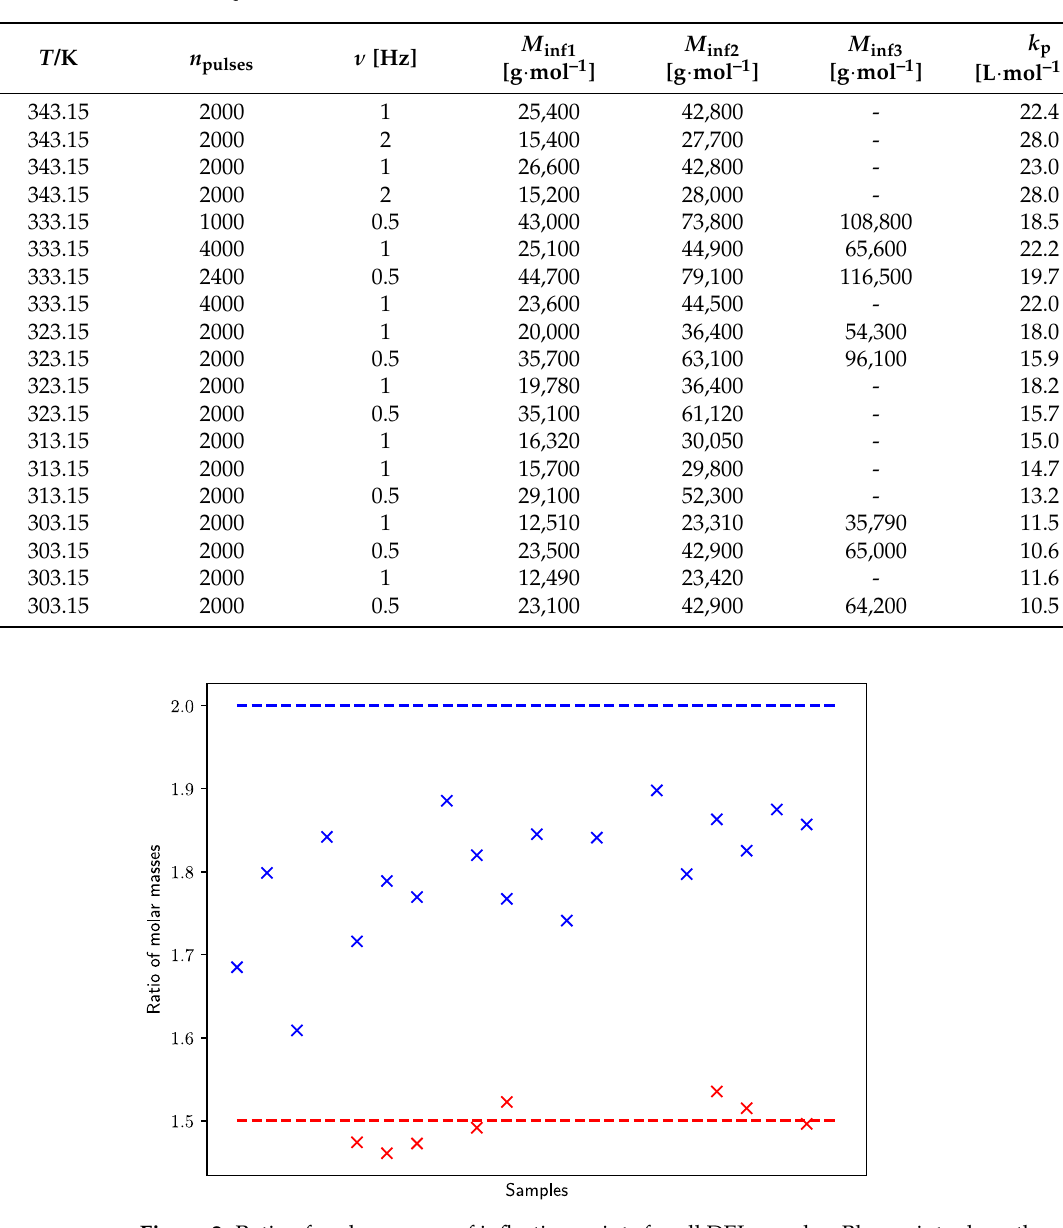
Figure 2. Ratio of molar masses of inflection points for all DEI samples. Blue points show the ratio of the second inflection point to the first one, while the red points show the ratio of the third inflection point to the second